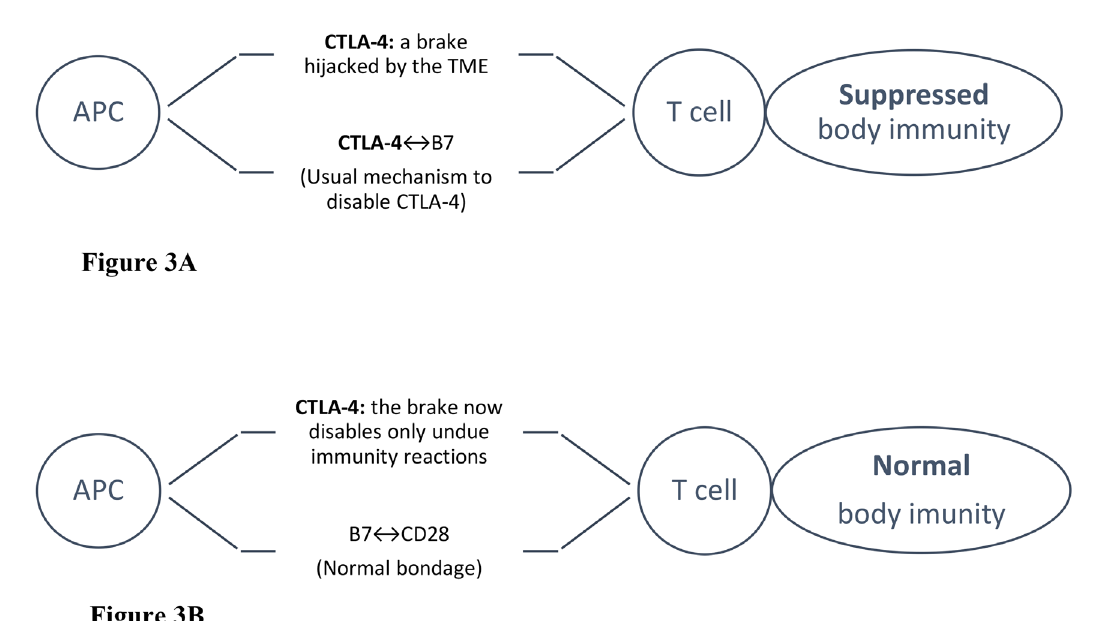
Figure 3. Scheme of CTLA-4 blockade. Tumor cells “hijack” immune checkpoints to disable host immunity. Illustrated are